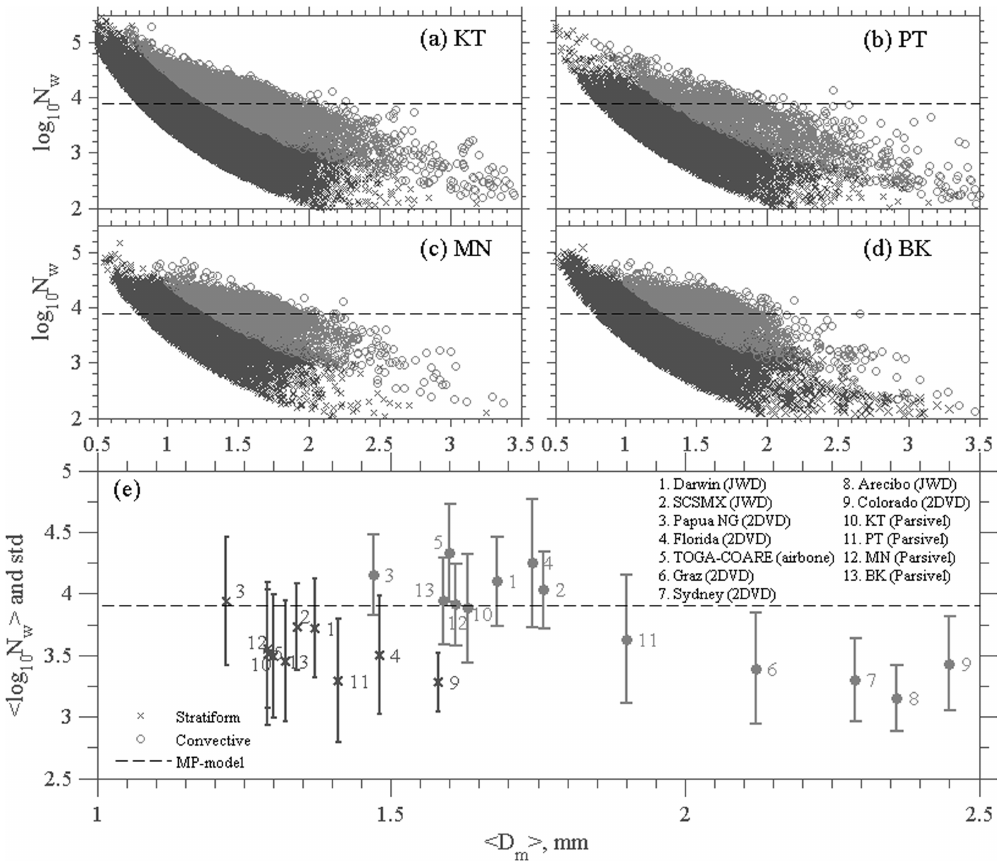
Fig. 4. (a) – (d) Scatterplot of N w in logarithmic scale versus D m for the four sites: black denotes stratiform and gray denotes convective, (e) the average value of log 10 N w (with ± 1 σ standard deviation) versus average D m for convective and stratiform, respectively, along with the data of Bringi et al. (2003). Dashed line is the Marshall–Palmer value (log 10 N w =3.9).